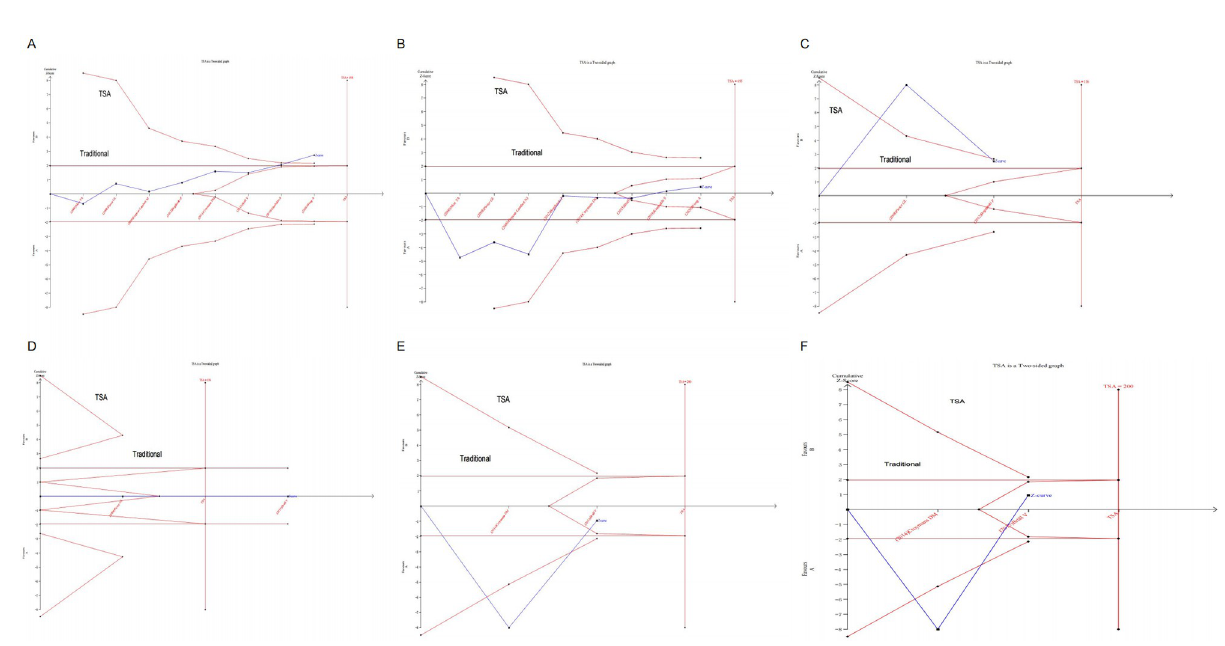
Fig 9. Sequential analysis of the trials (A): SBP (B): DBP (C): TNF- α (D): Endothelin-1 (E): sICAM-1 (F): sVCAM-1.